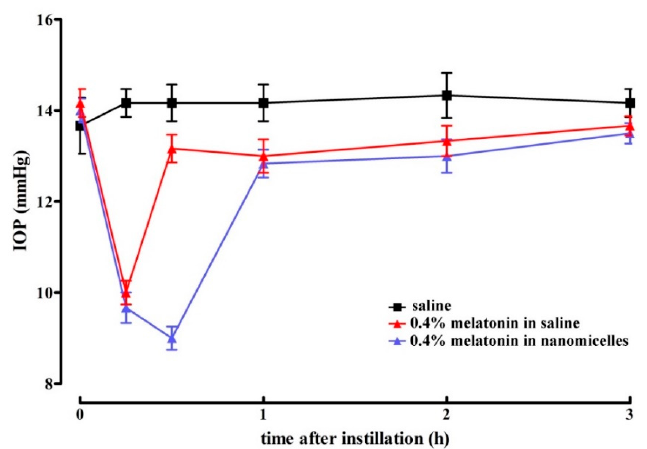
Figure 2. Lowering effect of melatonin formulated at 0.4% in saline or in nanomicelles in rats with normotensive intraocular pressure. No difference in the magnitude of lowering effect could be assessed among the different formulations. The nanomicellar formulation increased the duration of the hypotonizing effect. Values represent the mean ± standard error of the mean (SEM) of data from 3 rats (6 eyes).